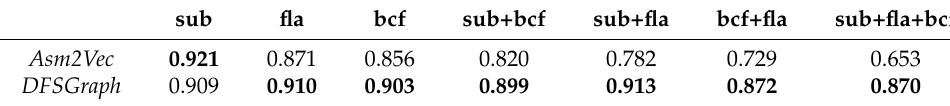
Table 4. Comparative experimental results between Asm2Vec and DFSGraph . sub fla bcf sub+bcf sub+fla bcf+fla sub+fla+bcf Asm2Vec 0.921 0.871